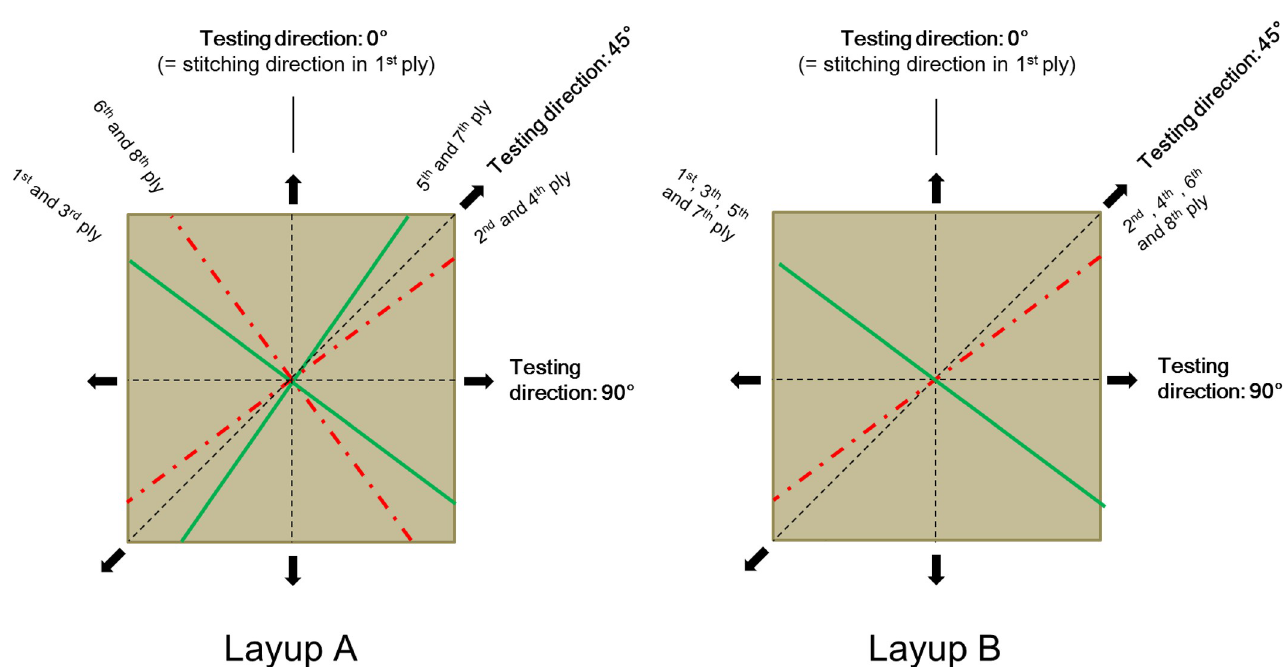
Fig 4. Schematic illustration of yarn directions in the multiaxial composite laminates with layup configurations A and B. The mechanical testing directions, 0˚, 45˚ and 90˚ are also indicated. Shown is an example of a biaxial fabric with + and–yarn angles above 45˚.